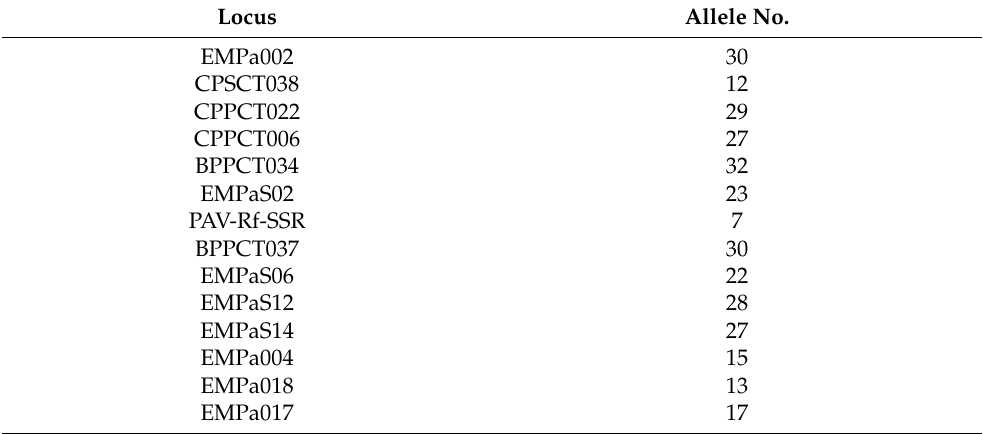
Table 4. Total allele number from the whole dataset (including polyploid samples) after alignment. Locus Allele